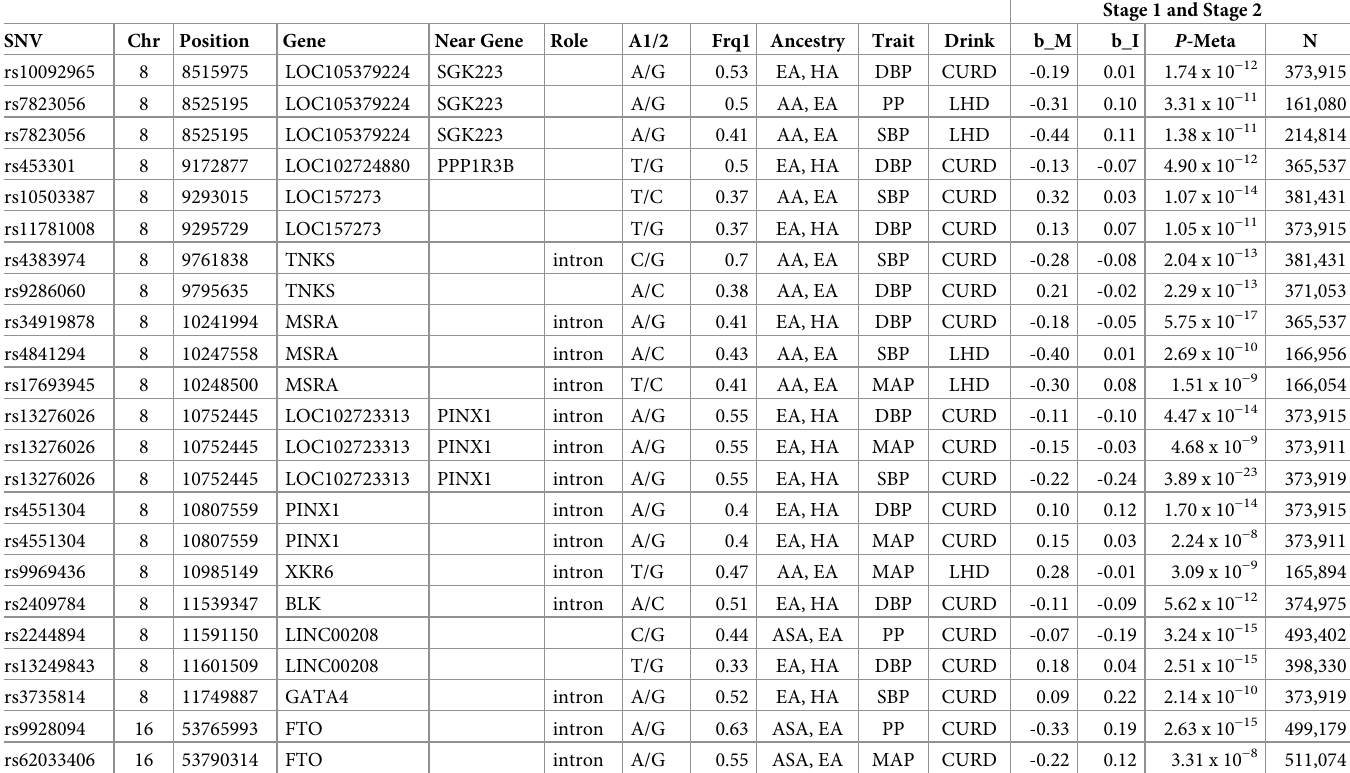
Table 4. Novel SNVs/Genes associated with BP traits in Multi-ancestry meta-analysis in combined Stage 1 and Stage